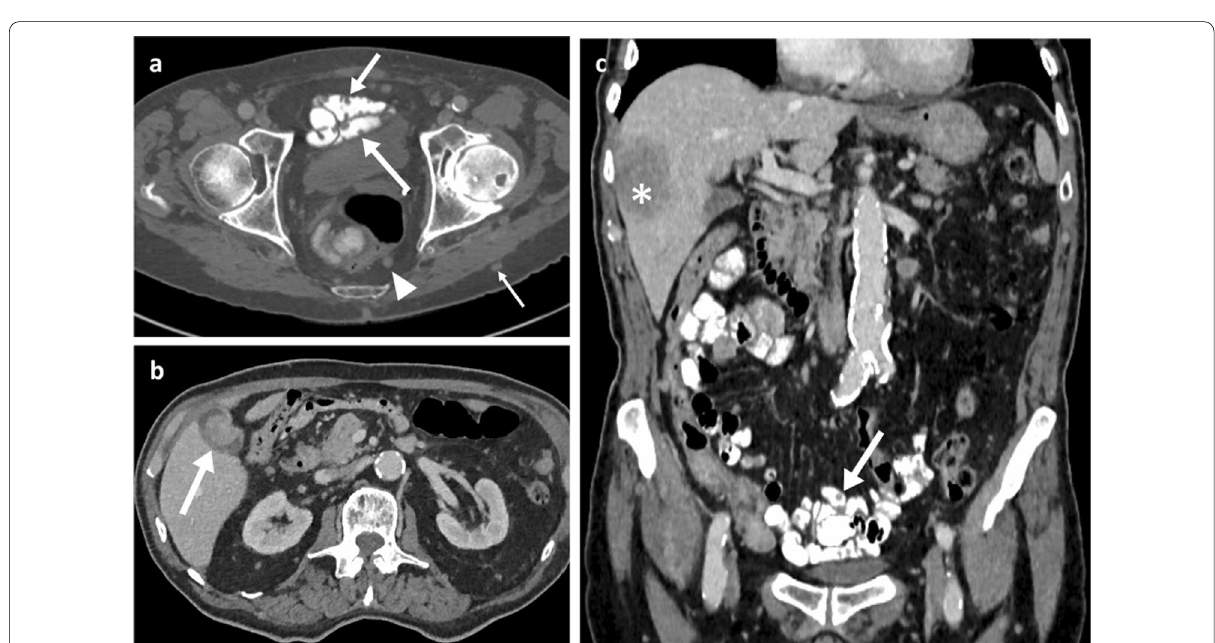
Fig. 4 Oral and intravenous portal phase contrast-enhanced CT axial ( a , b ) and coronal ( c ) of an 85-year-old male patient with numerous small melanoma metastases throughout the bowel with nodular mucosal thickening (arrows in a , c ), metastatic peritoneal nodules (arrowhead in a ), gallbladder metastasis (arrow in b ), liver metastasis (* in c ) and subcutaneous metastasis (thin arrow in a